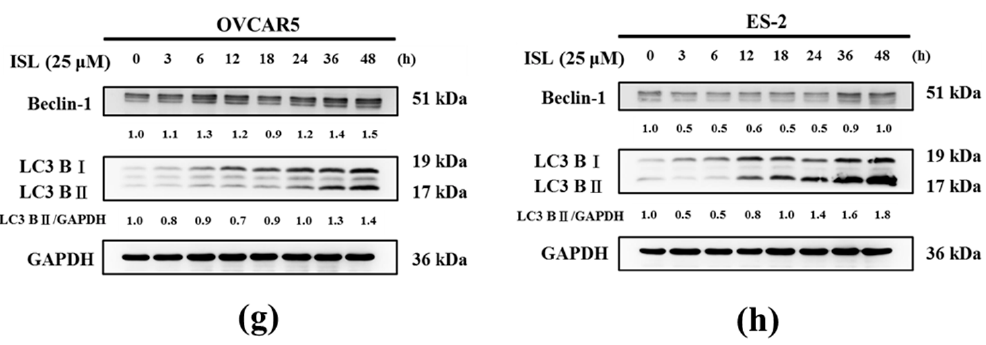
Figure 3. ISL induces the expression of autophagy and apoptosis-associated protein in ovarian cancer cells. OVCAR5 and ES-2 cells were treated with ISL (10, 25, 50 µ M) for 48 h ( a – d ) and treated with ISL 25 µ M for 3, 6, 12, 18, 24, 36, and 48 h ( e – h ). Cell lysates were separated by SDS-PAGE and analyzed on western blots with the indicated antibodies. GAPDH was used as a loading control. The values of the band intensity are expressed as the ratio (cleaved PARP or LC3B-II or cleaved caspase-3 or Bax/Bcl-2 or Beclin-1:GAPDH) relative to control.